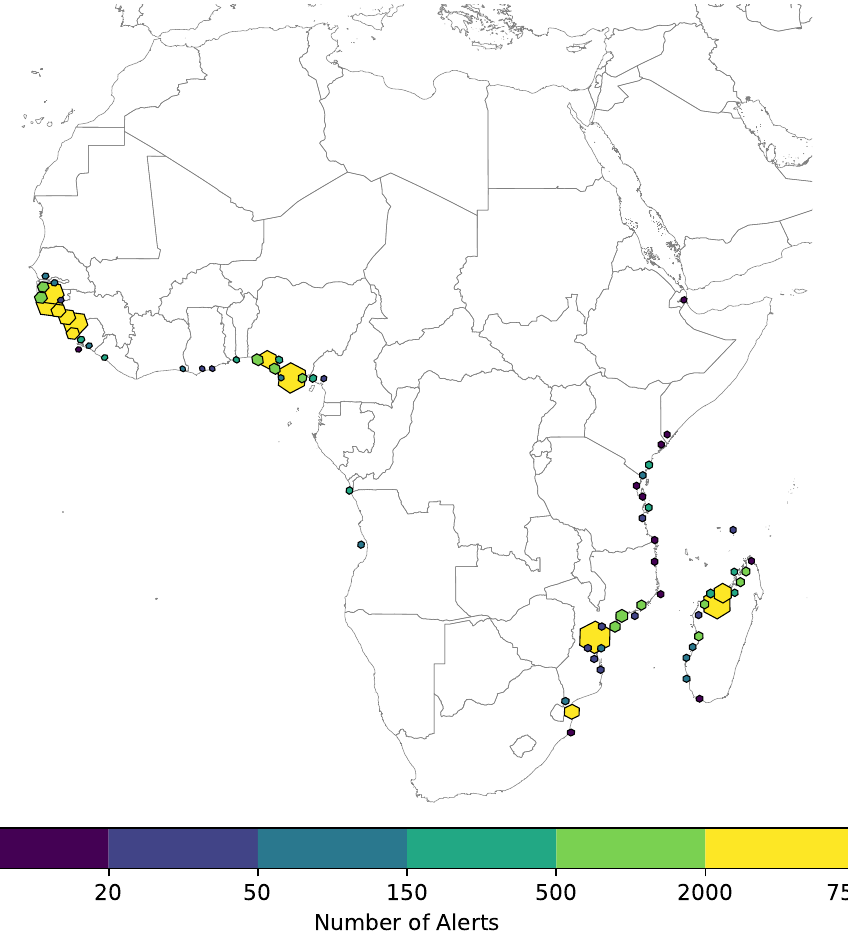
Figure 7. The mangrove loss alert hot spots throughout Africa. The hexagon sizes indicate the number of alerts, as does the